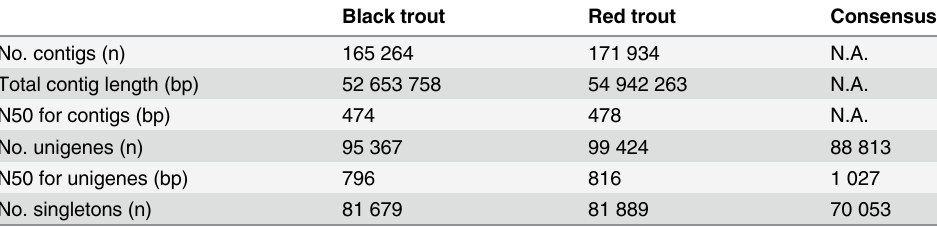
Table 2. Summary statistics of de novo assembly results of two common coral trout